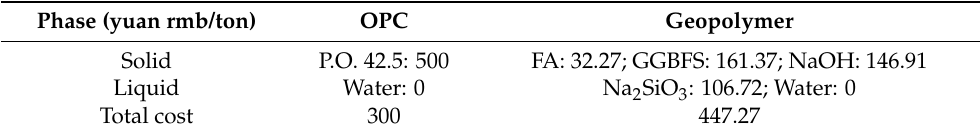
Table 7. Assessment of the cost of two types of soft soil stabilizers. Phase (yuan